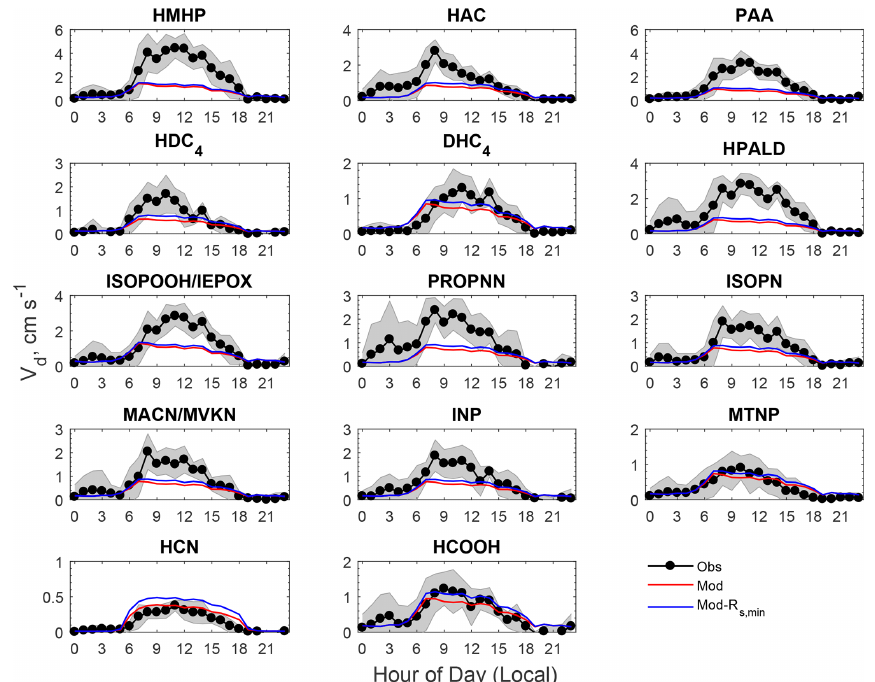
Figure 4. Comparison of averaged diel cycles of observed and modeled dry deposition velocities ( V d ) of oVOCs and HCN. The shaded area indicates the standard deviation of the observations. “Mod- R s , min ” refers to a sensitivity test in which R s , min was reduced by